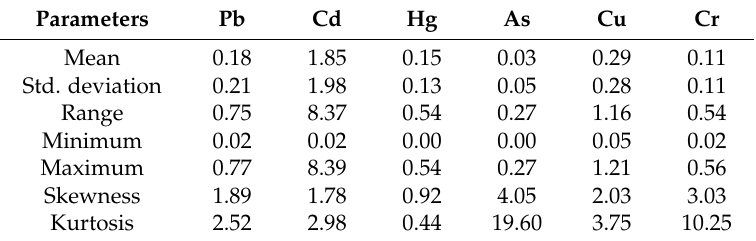
Table 5. Descriptive statistics of the accumulation factors of cabbage for different heavy metals (dry weight). Parameters Pb Cd Hg As Cu Cr